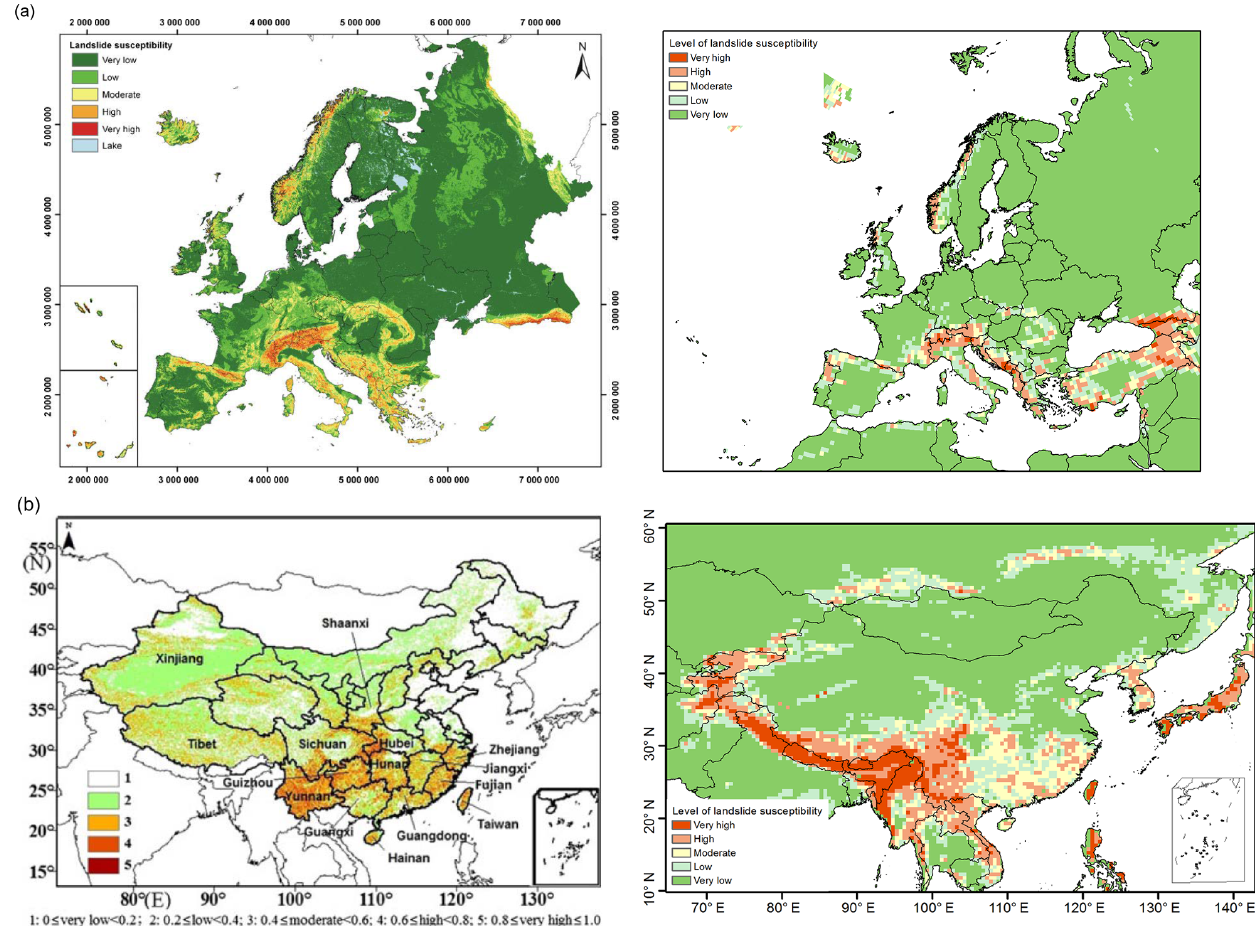
Figure 6. Comparison of existing studies with the related parts of this